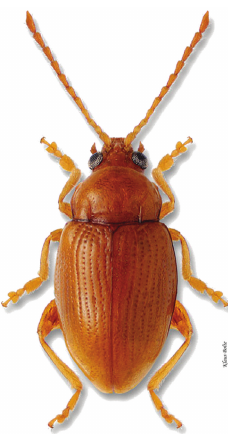
Figure 1: Neocrepidodera ferruginea , dorsal habitus. Body length, 3.5mm, excluding